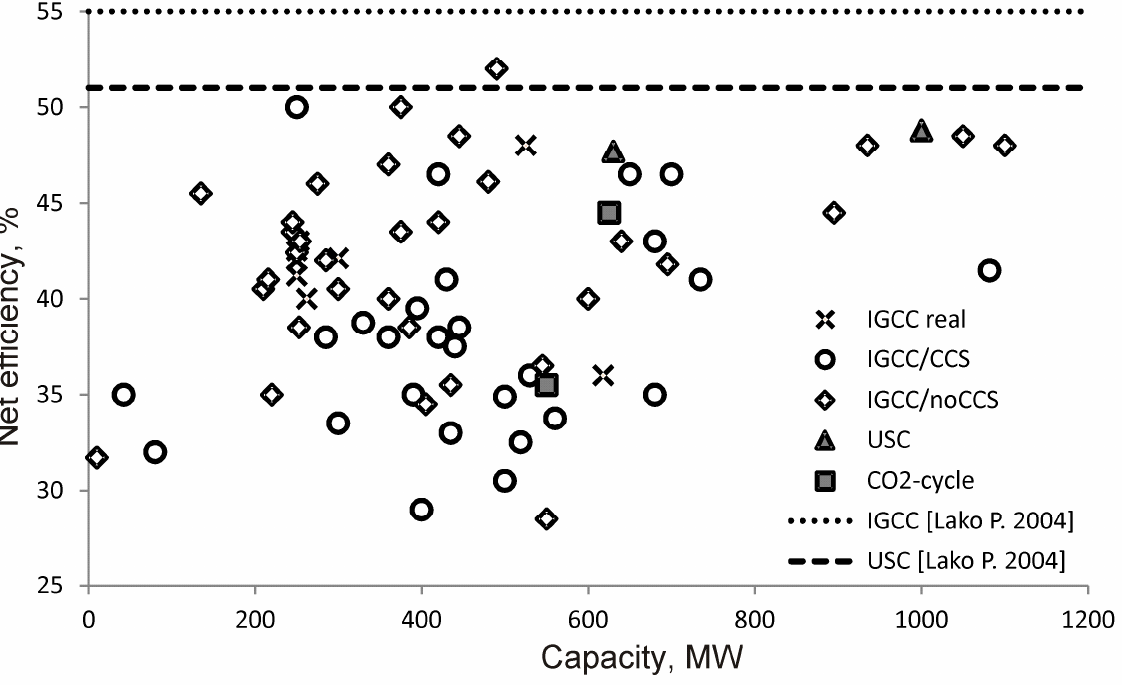
Figure 1. Distribution of coal power plants net efficiency according to the literature. Crosses—real IGCC plants; diamonds—calculated IGCC plants without CCS; circles—calculated IGCC plants with CCS; triangles—high-efficiency coal power plants with ultra-supercritical steam parameters; squares—calculated coal power plants using CO 2 as working fluid; lines—forecast [53].